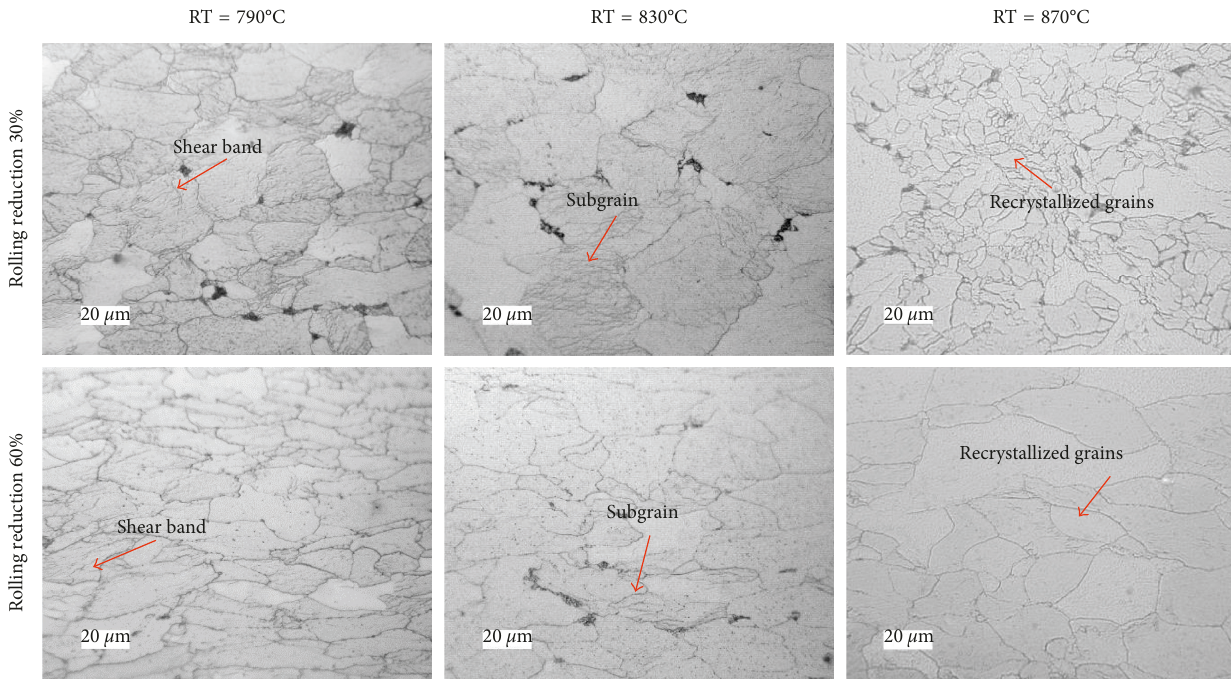
Figure 3: The microstructure of rolled mild steel affected by rolling temperatures of 790, 830, 870 ° C, and rolling reduction of 30% and 60%. Table 2: Mean equivalent diameter (D 0 ) of ferrite grains as a function of the rolling temperature and rolling reduction %.